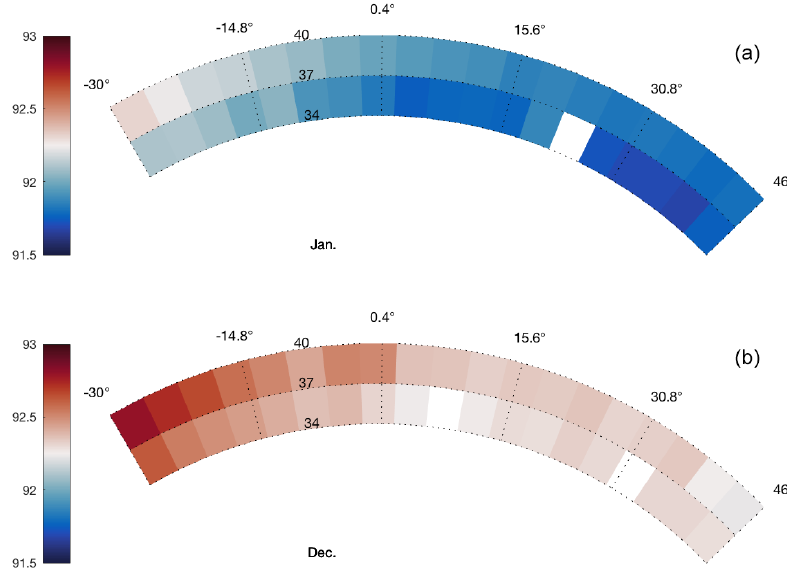
Figure B1. Range from the ADCP to the ice base in metres (colour) in January (a) and December (b) in polar coordinates.